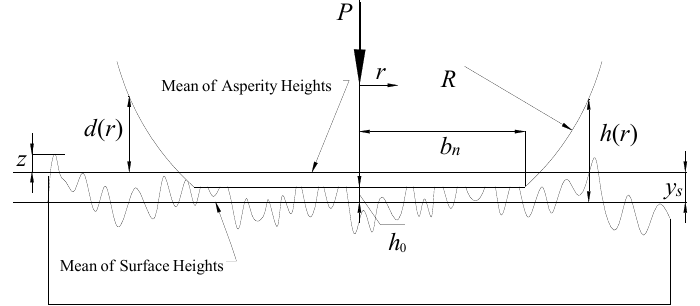
Figure 1. Contact model of rigid sphere and nominally rough flat [22].